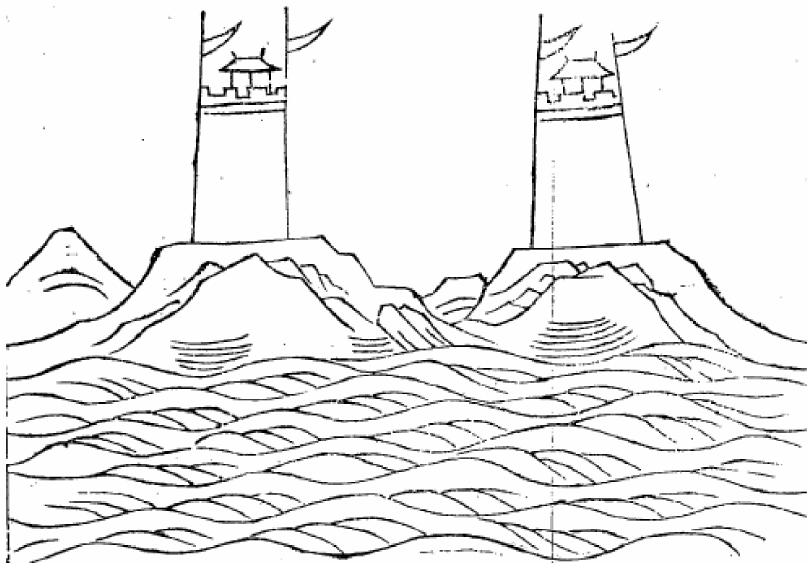
Figure 1. The dunhouzhi forts described in Jixiao Xinshu ( Joseonbon ). Reprinted with permission from Ref. [10]. 1998, Institute for Military History.